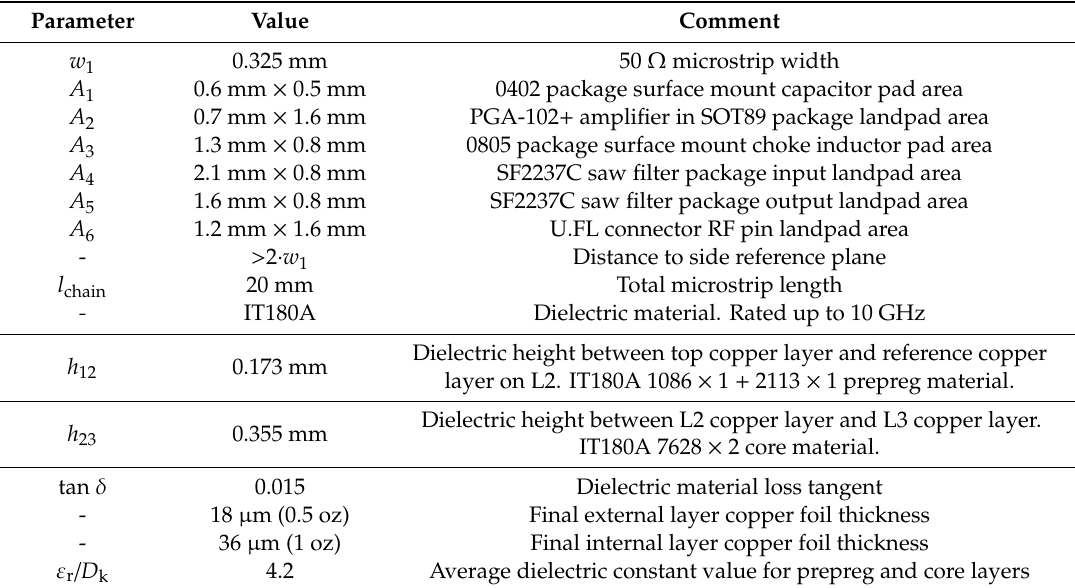
Table 2. Simulated amplifier chain landpad sizes.